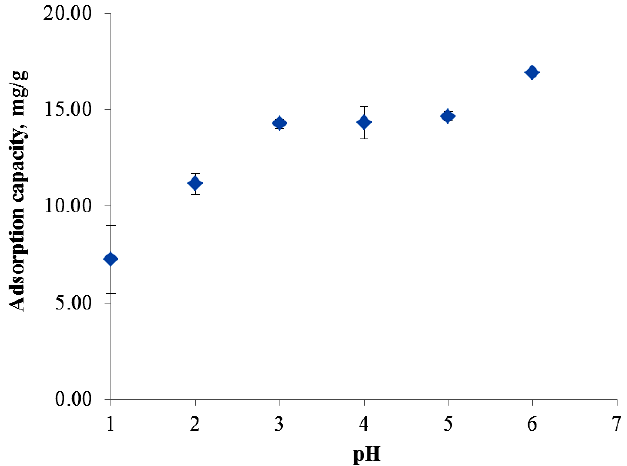
Figure 3. Adsorption capacity of peh-g-opefb towards nickel ion at different